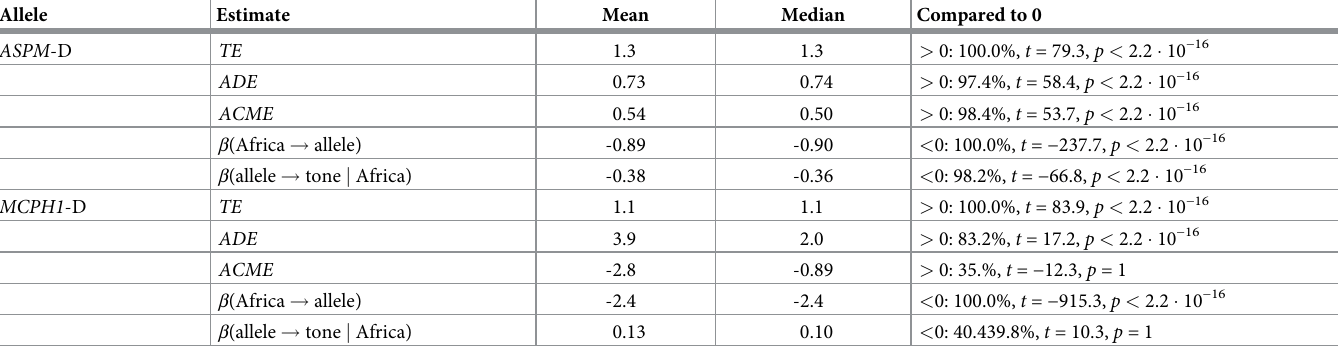
Table 13. Summaries of the mediation analysis for 1,000 restricted samples for tone counts . Same conventions as in Table 9. Allele Estimate